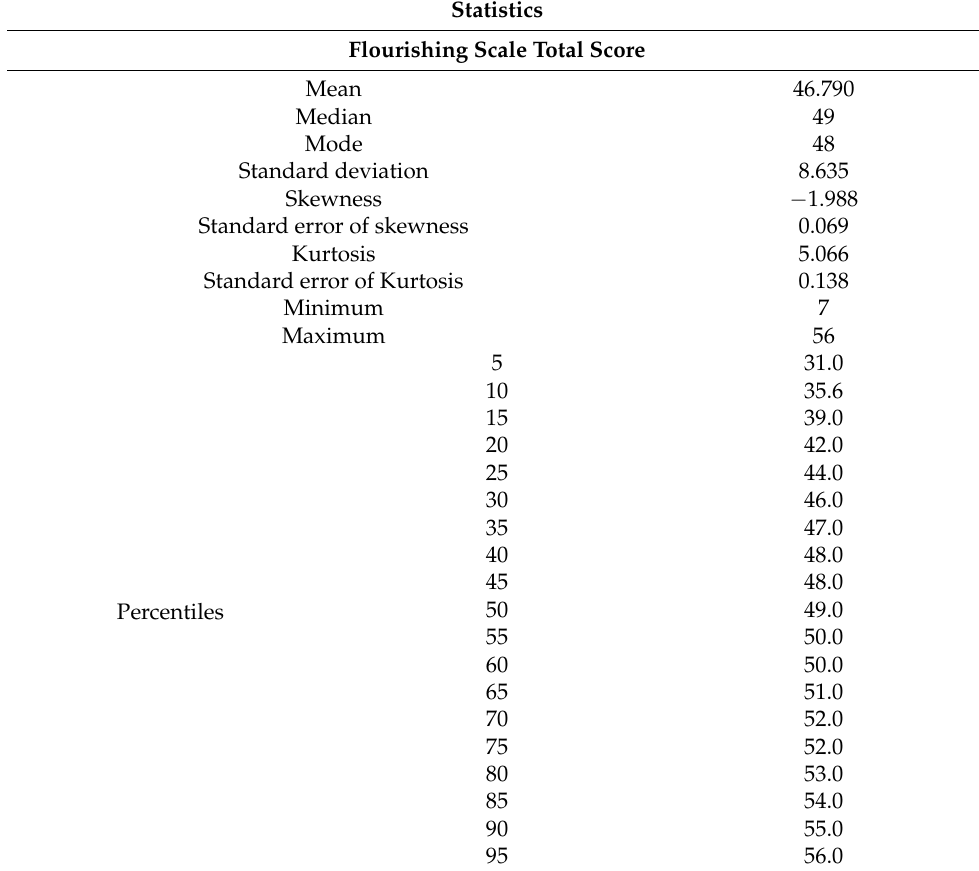
Table 6. Descriptive statistics and Flourishing Scale (FS) norms for the total score (percentile